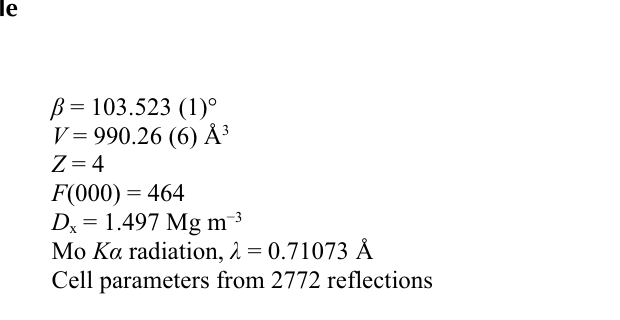
Partial crystal packing for the title compound showing molecules linked by π – π interactions and hydrogen bonds (dashed